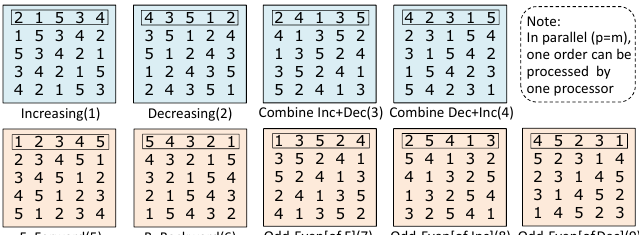
Figure 9. An example of the top nine (knapsack) orders and their Latin squares (of m permutations) for m = 5 knapsacks and C = (66, 26, 80, 96, 70).